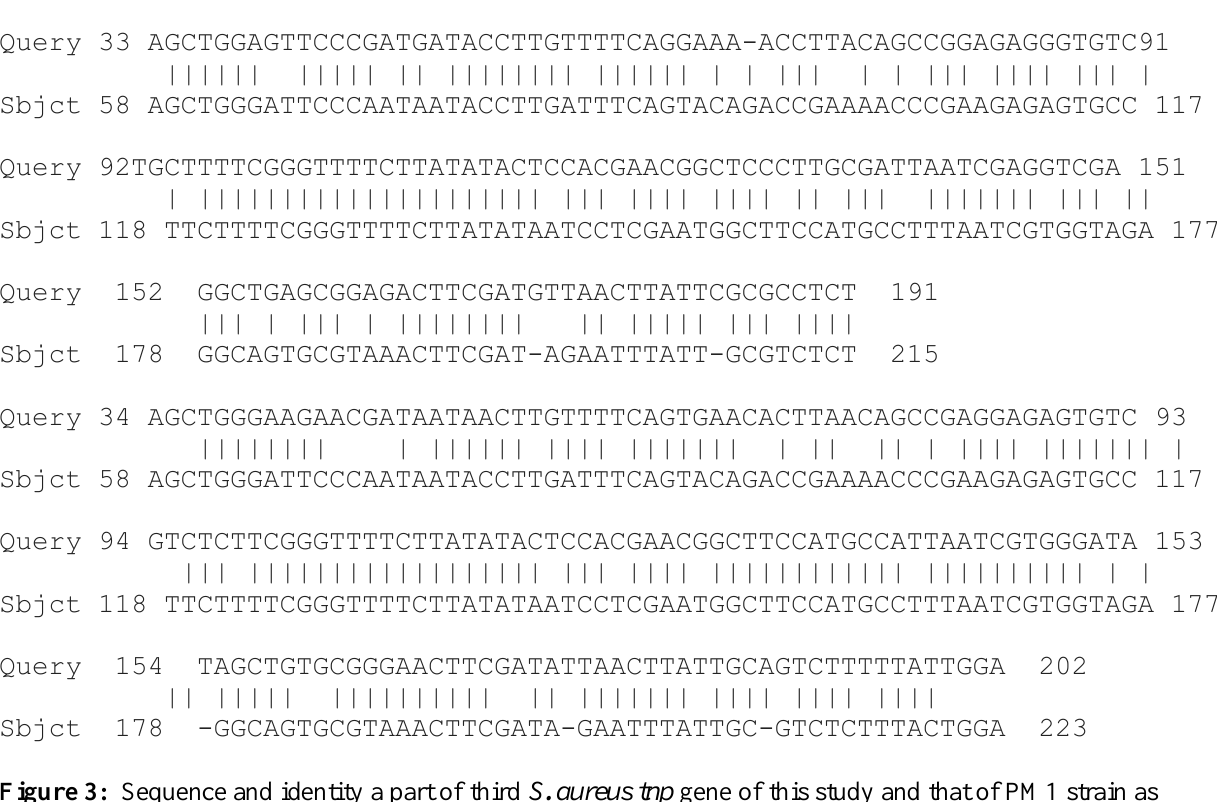
Figure 2: Sequence and identity a part of S. aureus tnp gene of this study and that of PM1 strain as reported in NCBI (accession no. AB699882.1).